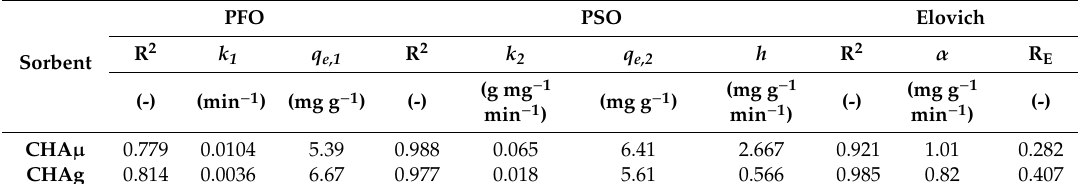
Table 2. Pseudo-First-Order model (PFO), Pseudo-Second-Order Equation (PSO), and Elovich parameters for CHA µ and CHAg and the relative R 2 values.